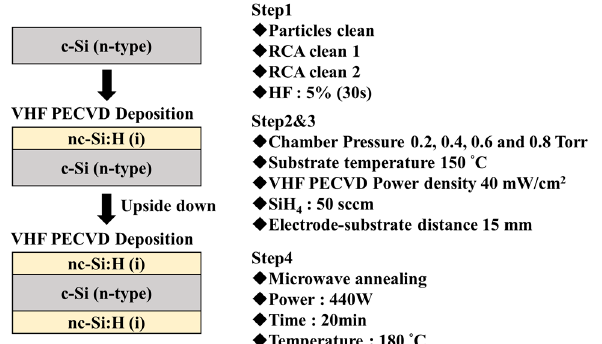
Figure 3. Fabrication process flow of the deposition of nc-Si:H on an n-type crystalline silicon sub-